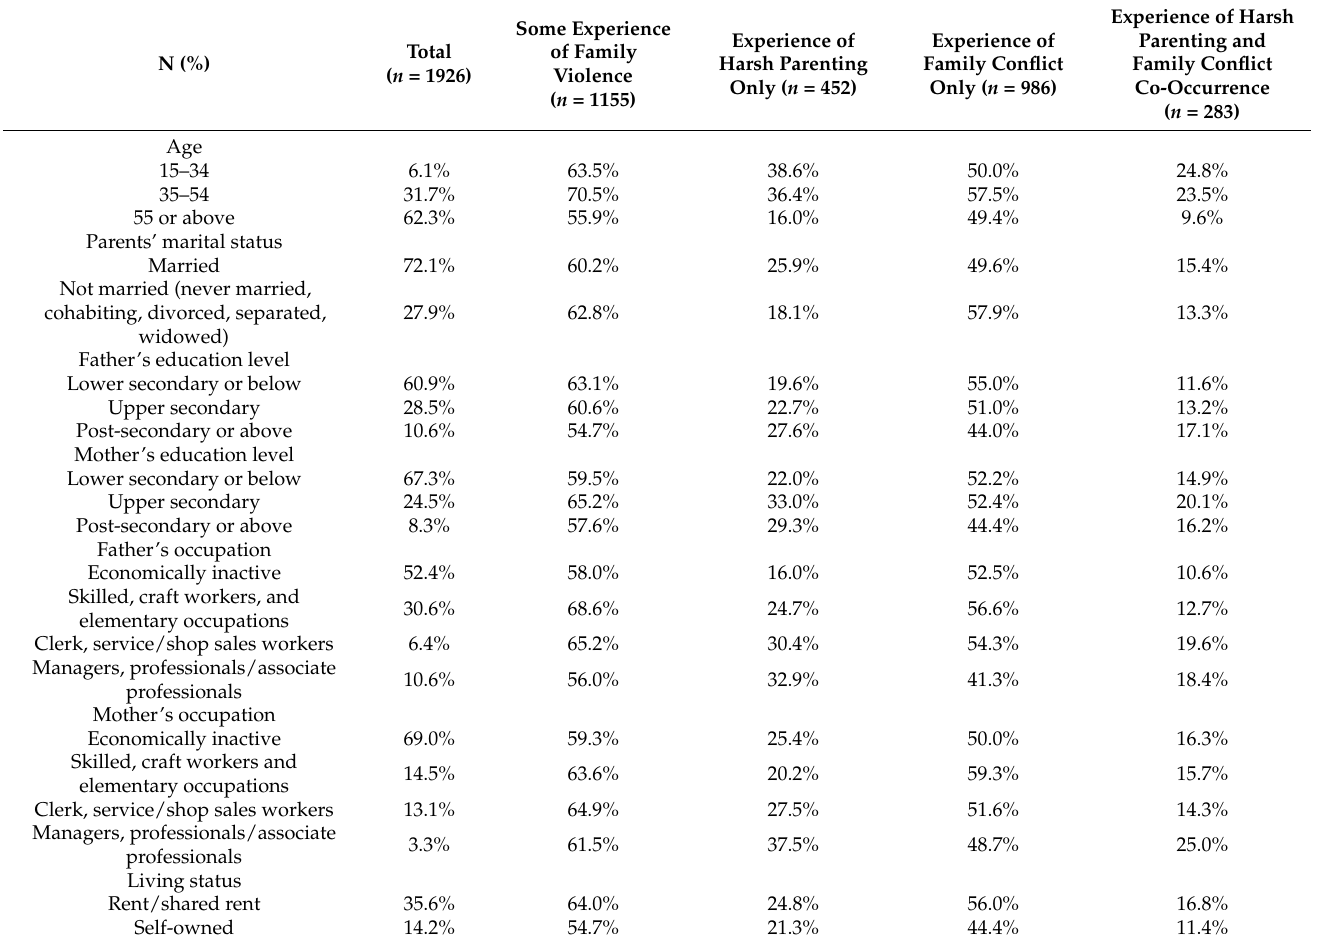
Table 1. Prevalence of harsh parenting and family conflict by demographic